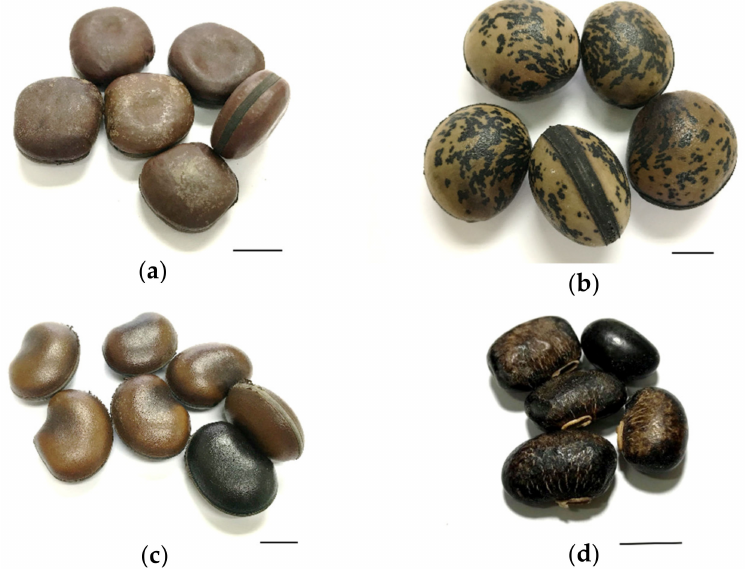
Figure 1. Characteristics of Mucuna seeds ( a ) M . gigantea (MGG), ( b ) M. interrupta (MIT), ( c ) M. monosperma (MMM), ( d ) M. pruriens (MPR). The indicated scale of each figure was 1 cm in